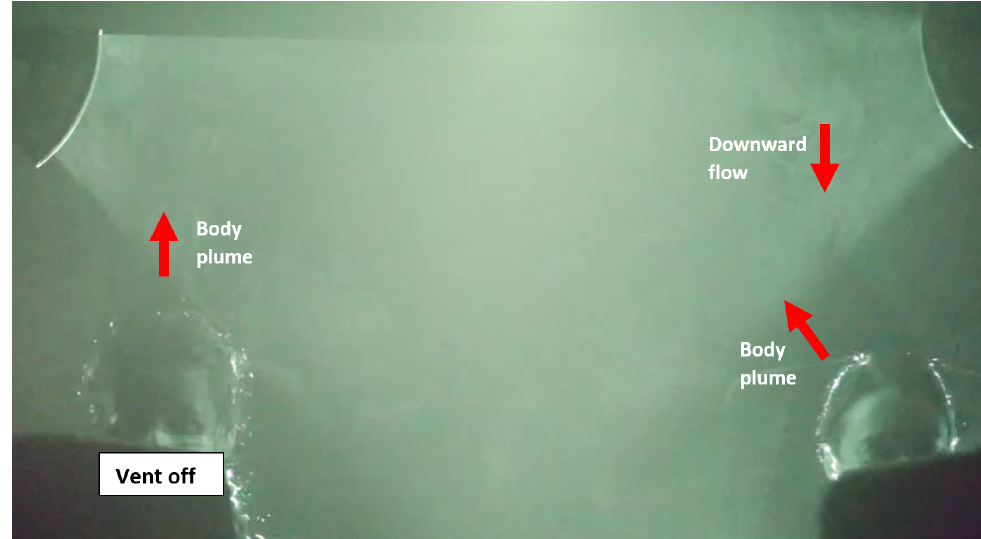
Figure 13. Snapshot of flow visualisation experiment at end of carriage during unventilated condi- tions. Red arrows indicate direction of persistent air flow.